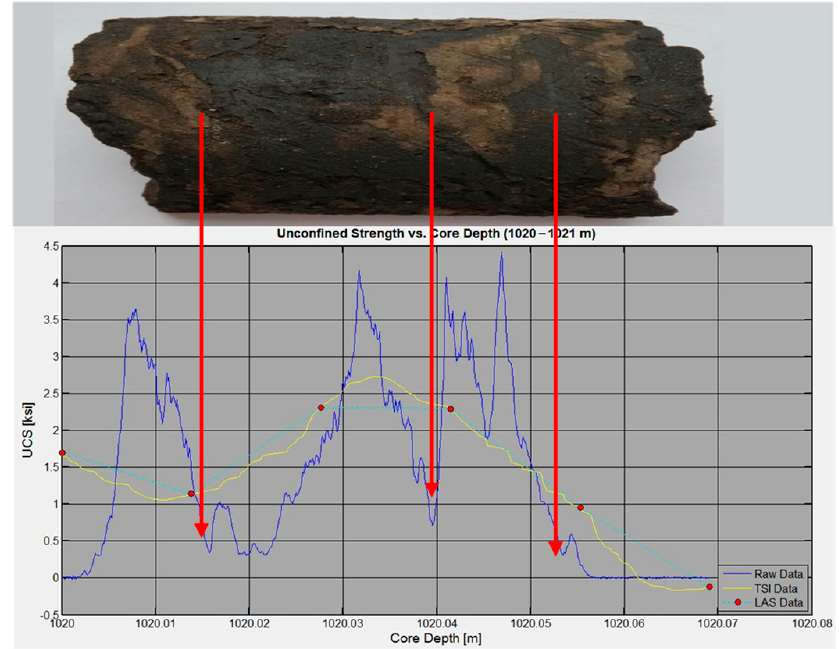
Figure 7. Core scribe test results.